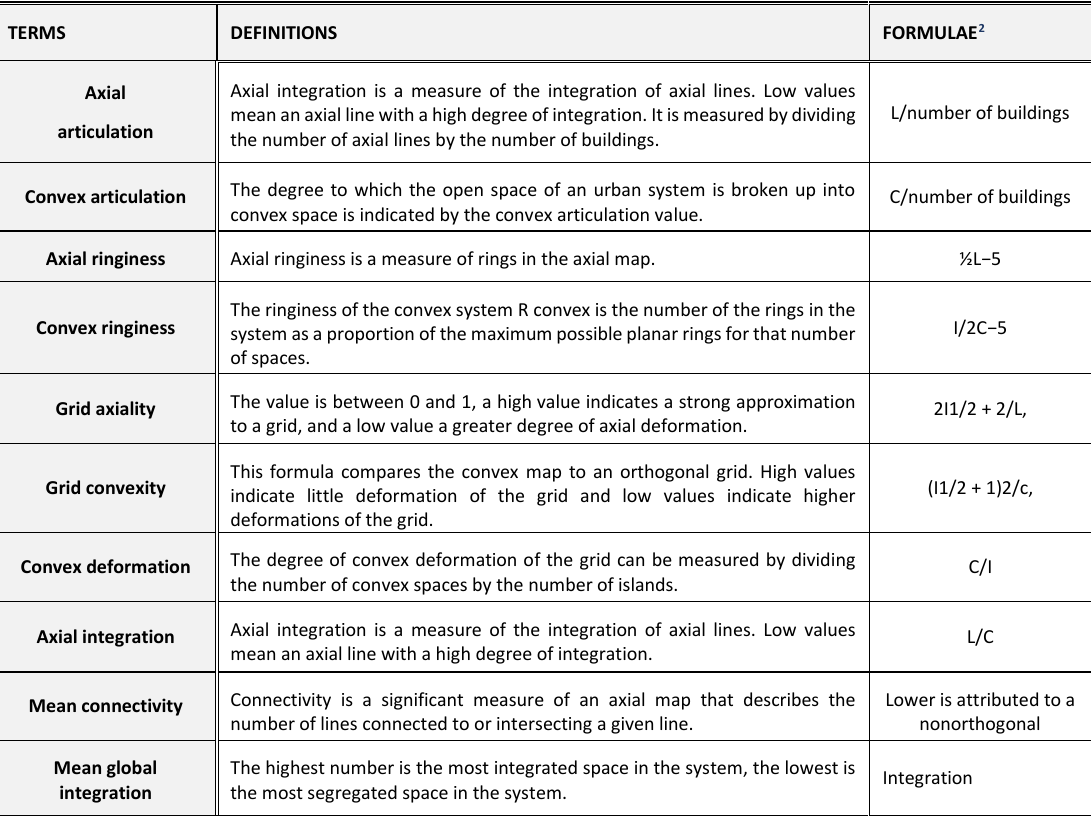
Table 2 Mathematical definitions of measures, complied by (Hillier, 1984; Kubat,